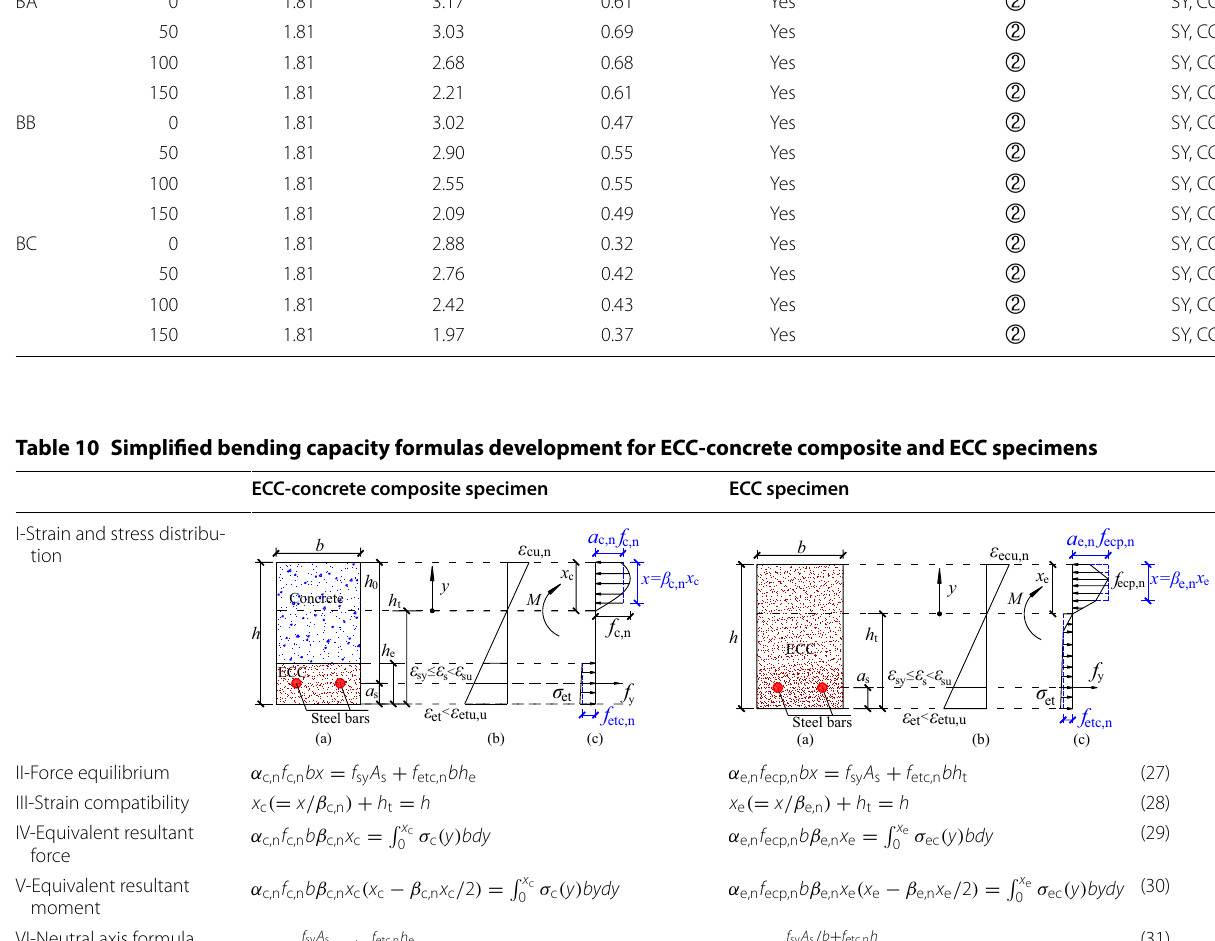
Table 9 Comparisons of experimental and predicted failure modes No.